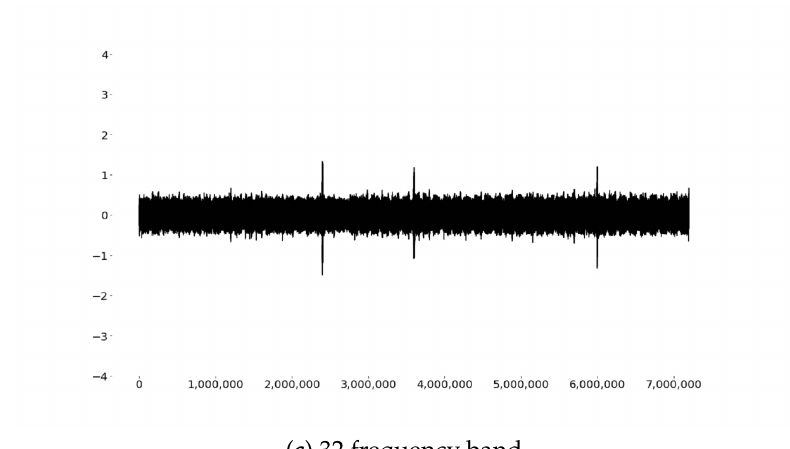
Figure 9. ( a ) The original data of a current sample. ( b ) The original data is filtered by 300 Hz low-pass. It can be seen that the two high amplitudes in the original data are filtered out, and the filtered signal is smoother. ( c ) The original data is filtered by the frequency band of 300 Hz to 600 Hz, and it can be seen that the signal amplitude after filtering is small and disorderly. We regard it as current noise.